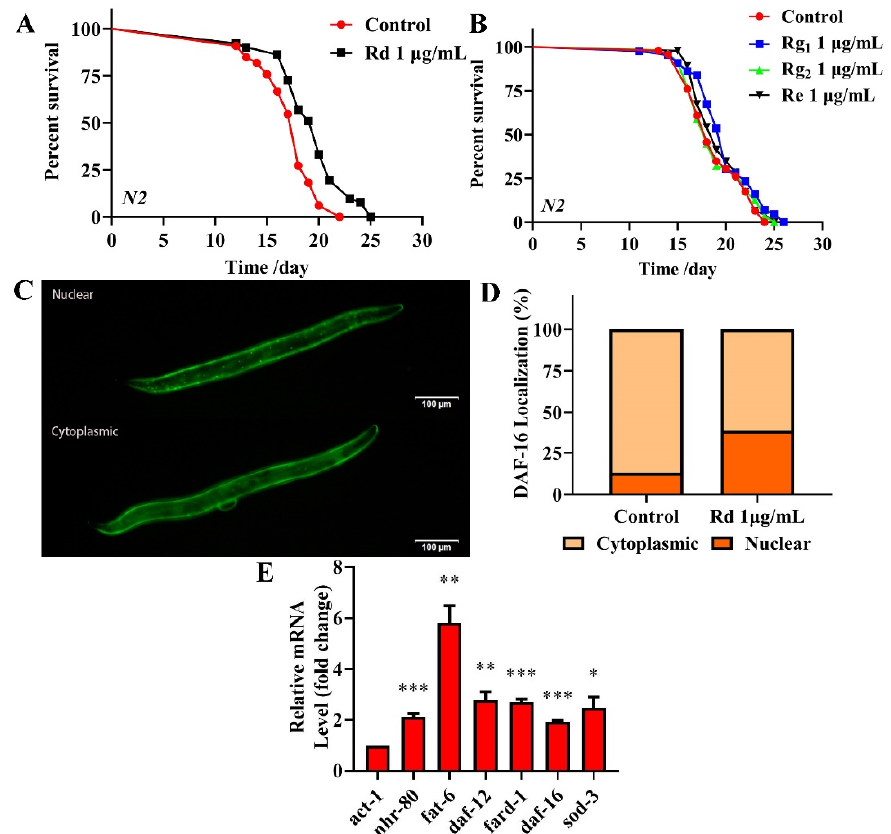
Figure 10. Effects of ginsenoside Rd, Rg 1 , Re and Rg 2 on the lifespan of C. elegans . ( A ) The survival of C. elegans treated with 0.1% DMSO (control) and 1 µ g/mL Rd, Rg 1 , Re and Rg 2 . Worms exposed to ginsenoside Rd survived longer than untreated worms ( p < 0.05). ( B ) Ginsenoside Rg 1 , Re and Rg 2 (1 µ g/mL) did not extend the lifespan of C. elegans . ( C , D ) Fluorescence images of DAF-16::GFP expression in ginsenoside Rd-treated and untreated worms. ( E ) mRNA levels of nhr-80 , daf-12 and daf-16 and the downstream genes fat-6 , fard-1 and sod-3 in C. elegans treated with ginsenoside Rd. The data were analyzed using a Student’s t-test. The values were shown as the mean ± SEM, *** p < 0.001, ** p < 0.01, * p < 0.05.